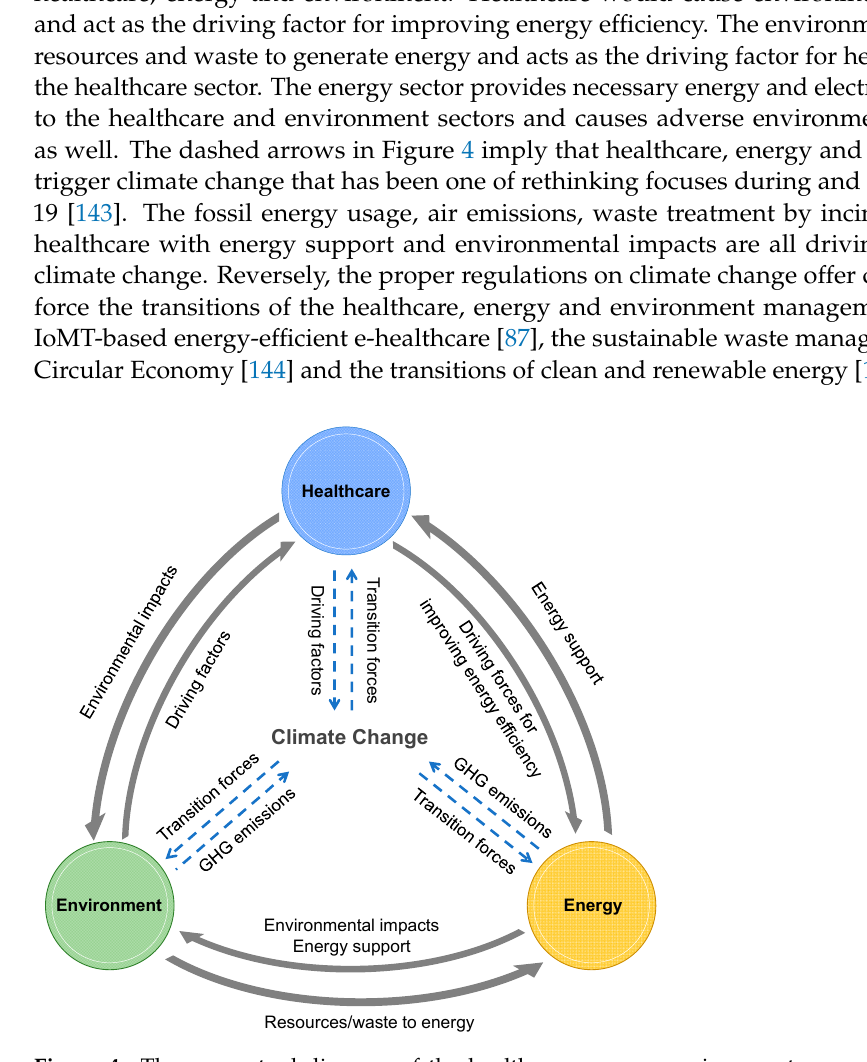
Figure 4. The conceptual diagram of the healthcare – energy – environment nexus under climate change constraints.